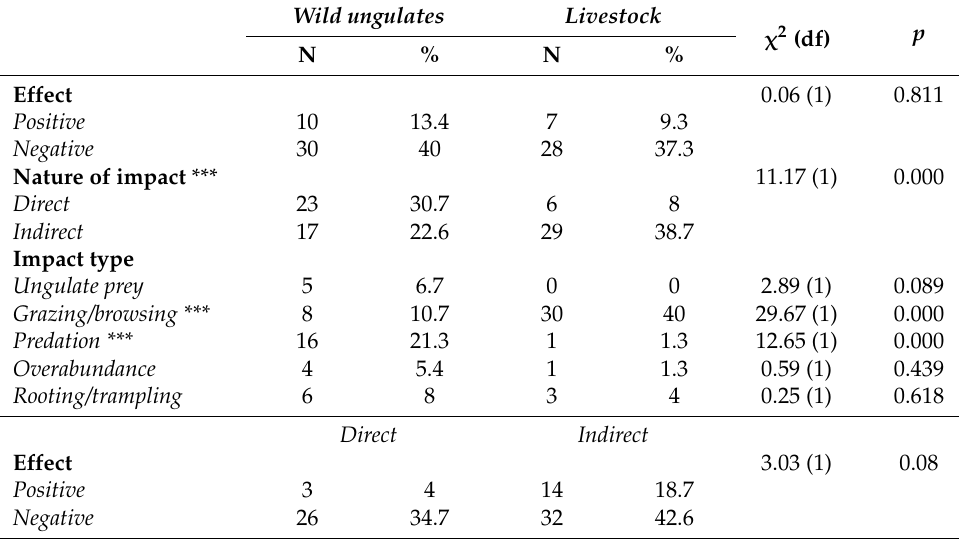
Table 1. The results of Pearson’s Chi-square tests with Yates continuity correction on ungulate-reptile interactions comparing wild ungulates and livestock. *** p < 0 .001.